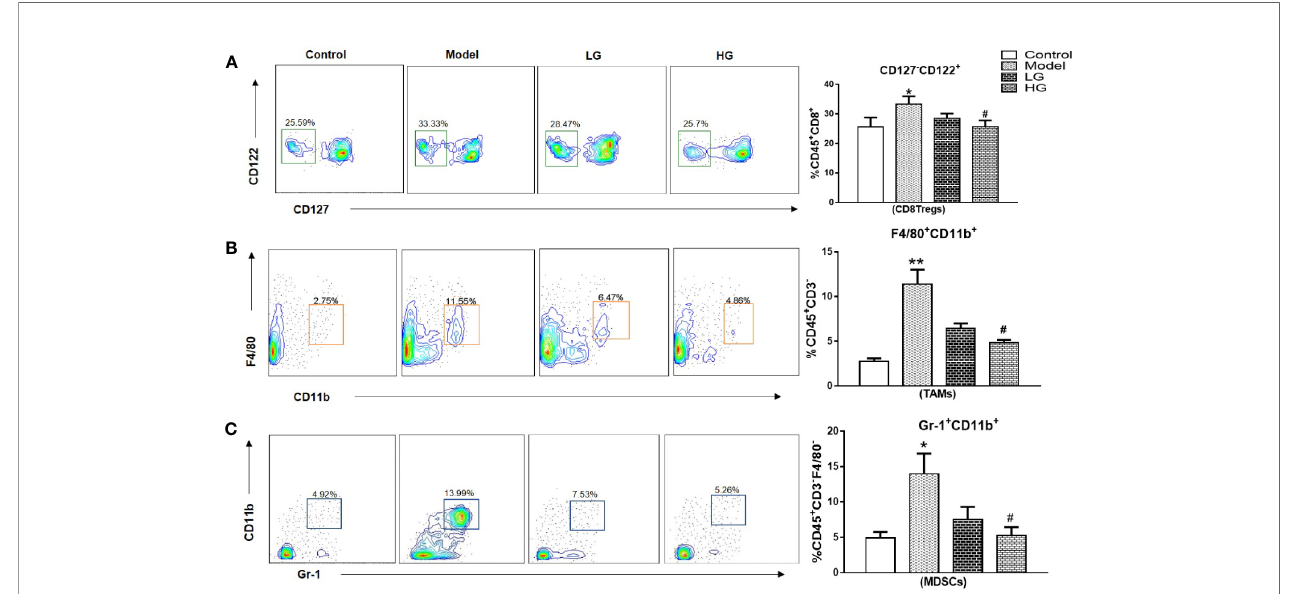
FIGURE 3 | The content of CD8 + Tregs, TAMs, and MDSCs in the immune microenvironment of hepatocellular carcinoma at 23 th weeks. (A) CD8 + Tregs level in the liver. (B) TAMs content in the liver. (C) MDSCs expression in the liver. CD8 + Tregs, TAMs, and MDSCs data in the liver cancer microenvironment were analyzed by ANOVA. The homogeneity test was fi rst performed, P > 0.05, the variances were uniform, and the LSD (L) test was used for multiple comparisons afterward, P < 0.05, the variances were not uniform. *p < 0.05, **p < 0.01 vs. control; # p < 0.05, vs. model.